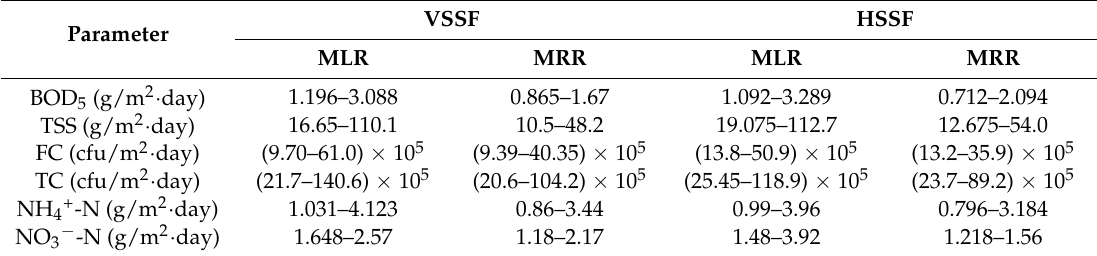
Table 4. MLRs and MRRs for VSSF and HSSF wetland units polishing stream water spiked with a nitrogen source.